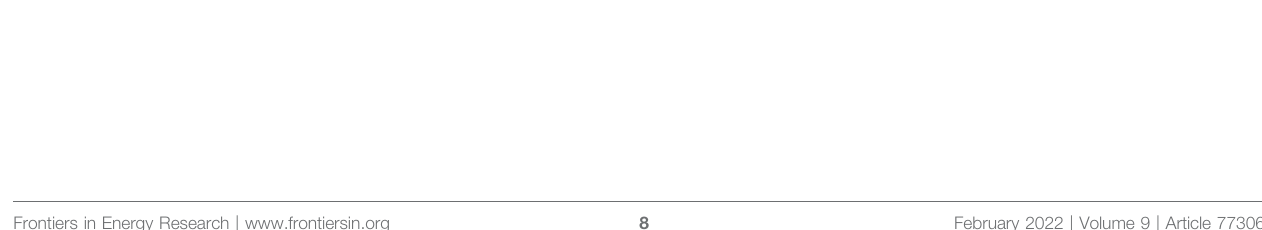
Frontiers in Energy Research |